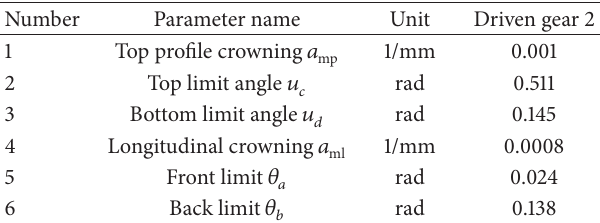
Table 2: Parameters of driven gear 2.